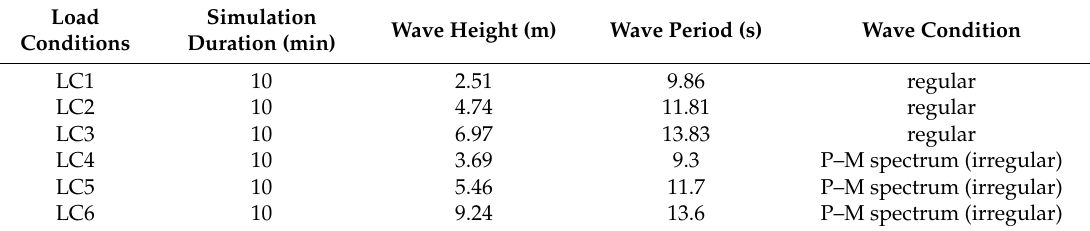
Table 4. Load-condition definitions for the regular and irregular waves.